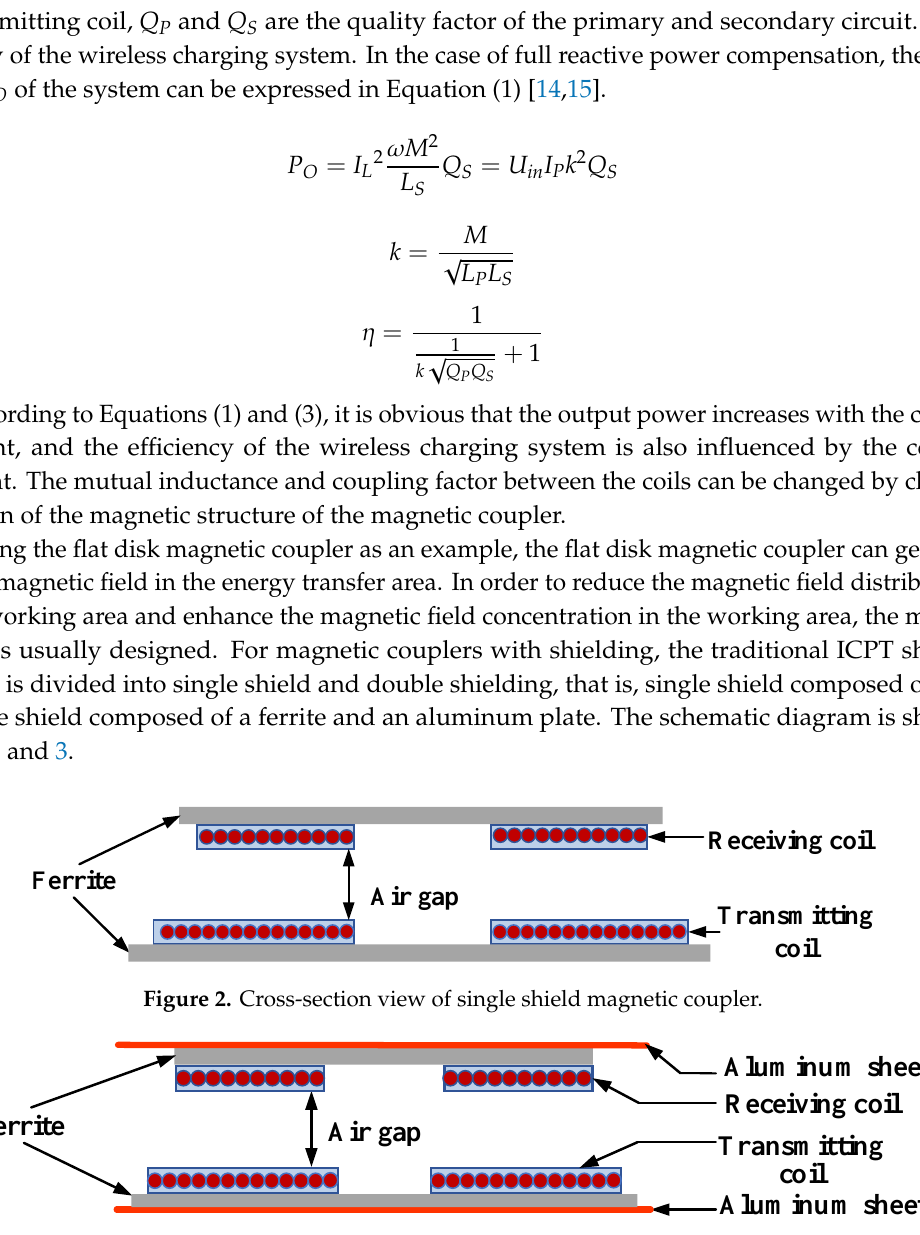
Figure 3. Cross-section view of double shield magnetic coupler of WPT system.